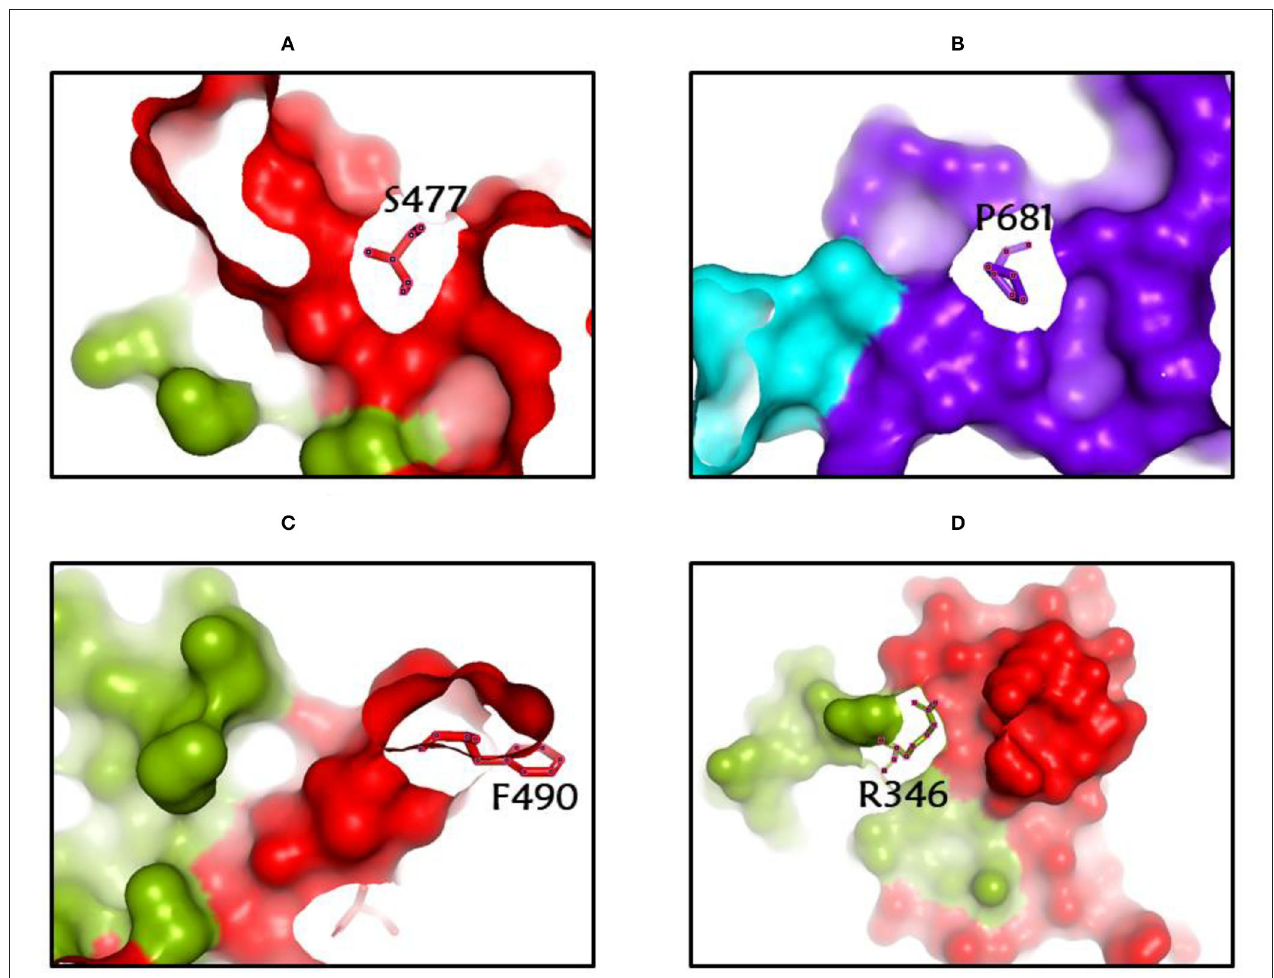
FIGURE 4 | (A-D) The most common spike glycoprotein residues (S477, P681, F490, R346) where diverse mutations occur, resulting in different SARS-CoV-2 VOCs, VOIs, and